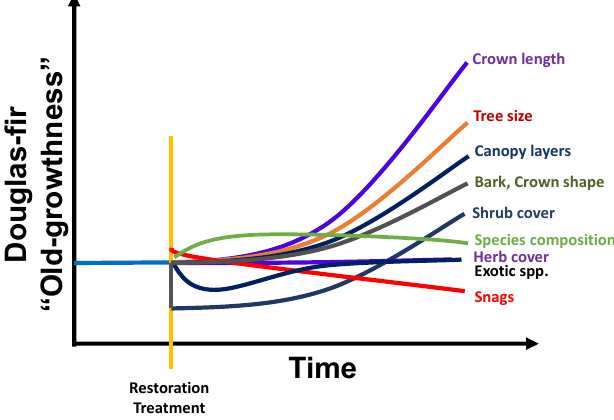
Figure 4. Schematic simplified hypothesis based on results about how different stand structural components responded to restoration treatments. Trends are in relative terms to allow an integrative overview. Douglas-fir “old-growthness” is a reflection of how closely conditions are to old-growth stands. Axis is scaled approximately in perspective to pre-treatment and typical old-growth conditions.